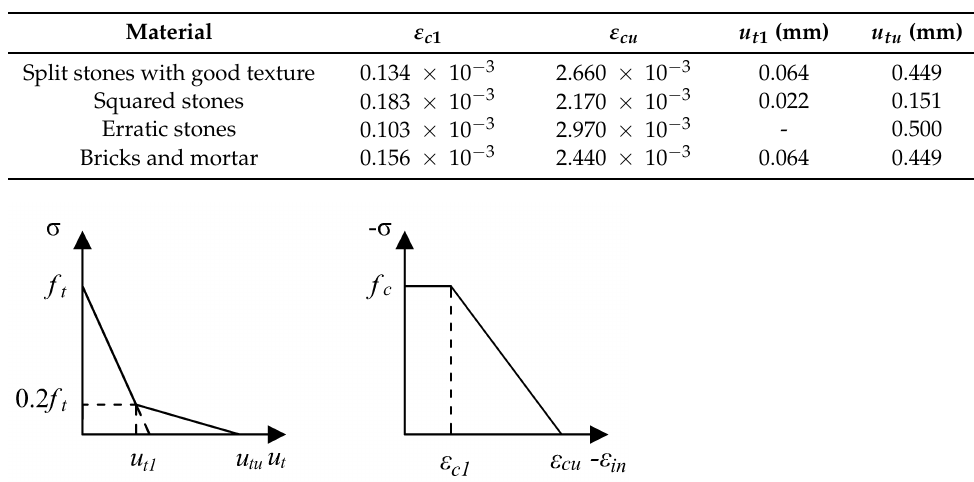
Table 3. Uniaxial compressive and tensile static responses for different masonry typologies.